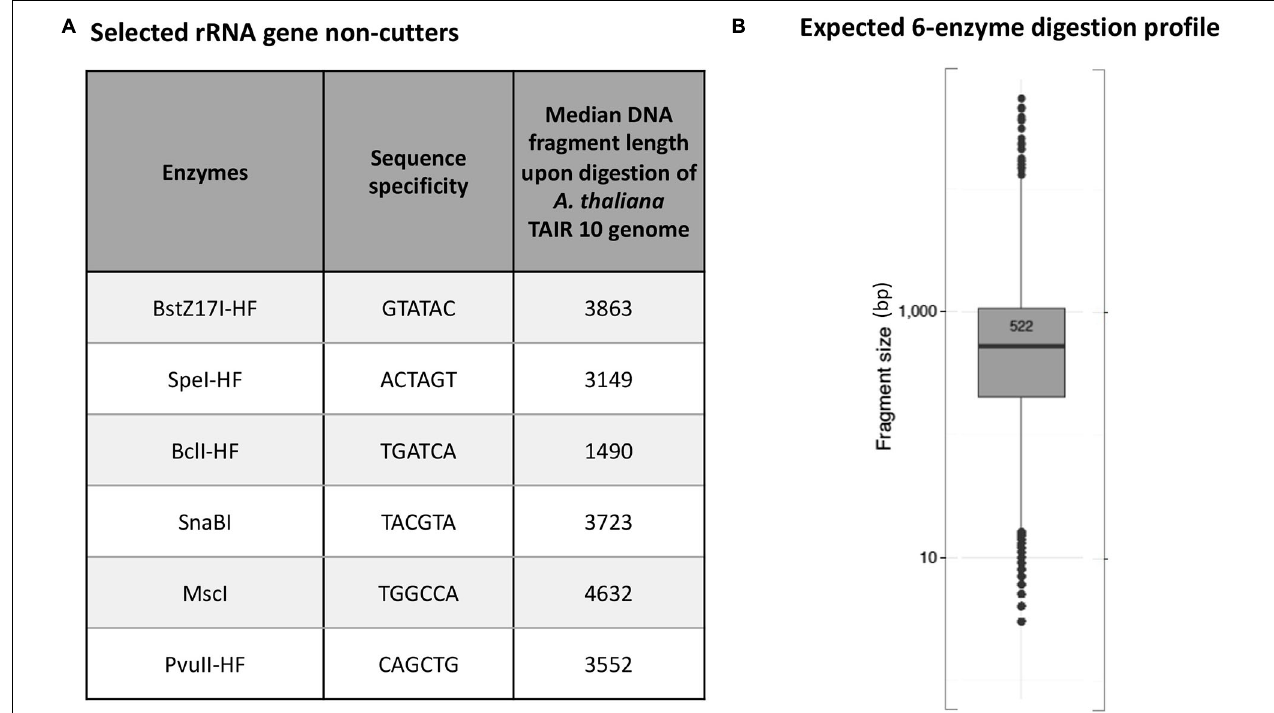
FIGURE 1 | Predicted 45S rRNA gene non-cutting restriction endonucleases used as a cocktail for digestion of genomic DNA. (A) Names and sequence specificities of the enzymes and median fragment sizes obtained upon in silico digestion of A. thaliana Col-0 genomic DNA. (B) Expected in silico digestion mean size and distribution for Col-0 genomic DNA subjected to digestion by the six-enzyme cocktail.